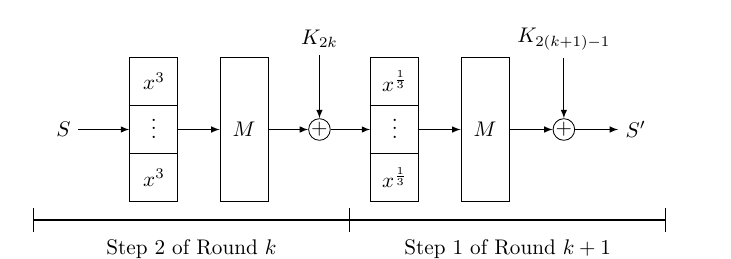
Figure 4: An adapted representation of a round of Rescue better suited for STARK